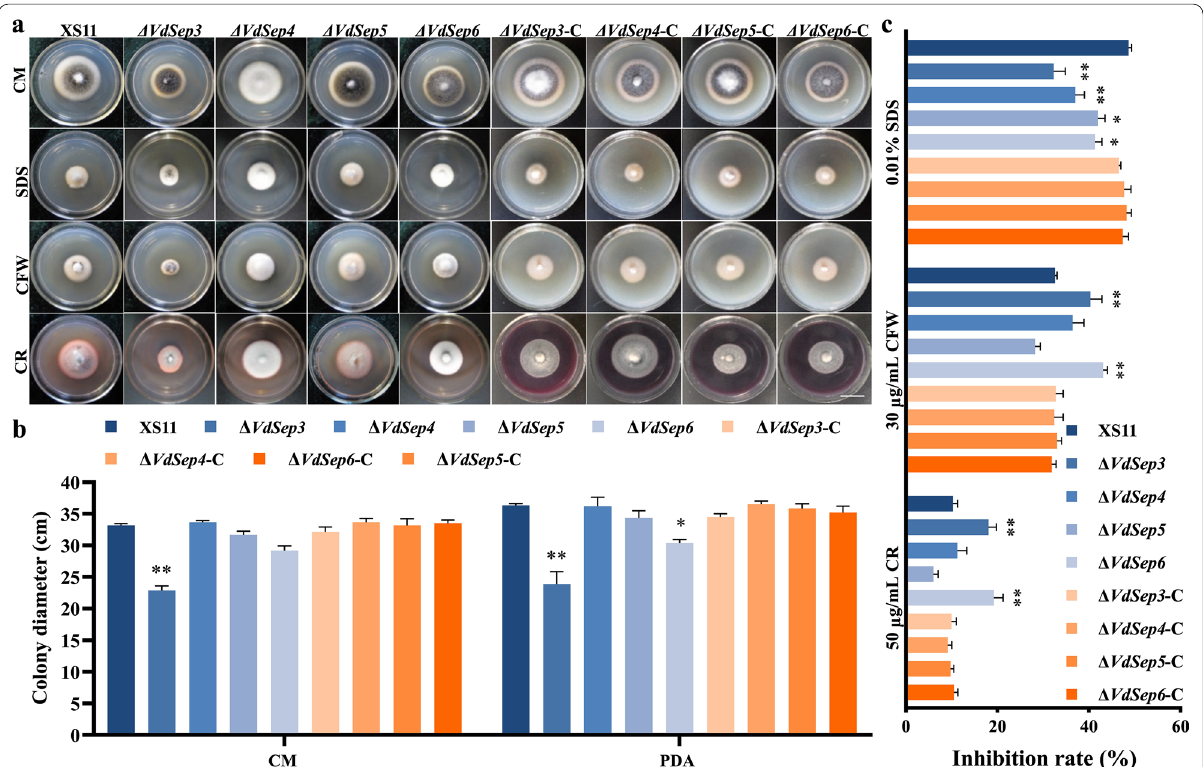
Fig. 3 Septins are involved in mycelial growth and cell wall integrity. a Colony of XS11 and mutants (Δ VdSep3 , Δ VdSep4 , Δ VdSep5, and Δ VdSep6 ) were grown on complete medium (CM) or CM containing 30 μg/mL calcofluor white (CFW), 25 μg/mL Congo red (CR), or 0.01% SDS for 10 days at 25 °C. Bar 0.617 cm. b Column diagram showing colony diameters of the indicated strains grown on CM or potato dextrose agar (PDA) for 10 days = at 25 °C. Error bars represent standard deviation based on three independent replicates (**, P < 0.01; *, P < 0.05). c Growth inhibition of the indicated strains by CFW (30 μg/mL), CR (25 μg/mL), or 0.01% SDS. The strains were cultured on CM with stress agents for 10 days at 25 °C. Error bars represent standard deviation based on three independent replicates (**, P < 0.01; *, P <